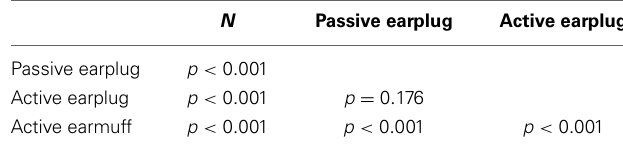
Table 6 | Results of pairwise comparisons between the different test conditions for different types of HPDs for combined up-down and front-back